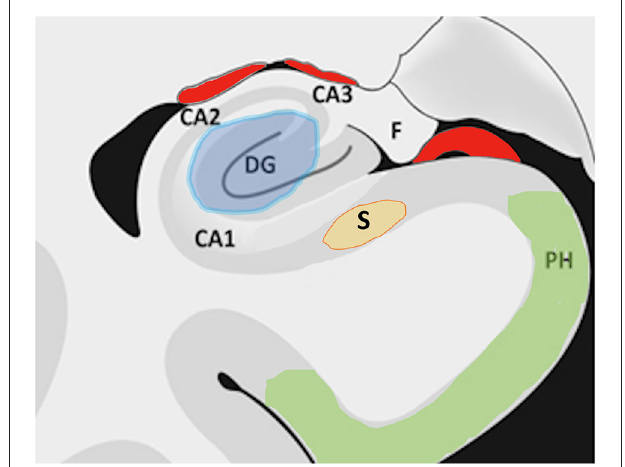
FIGURE 2 | Diagram of a coronal section of the temporal lobe that illustrates the size and location of the studied targets: in blue the hippocampus including dentate gyrus (DG) and Ammon fields C1–C3; subiculum (S); para-hippocampal cortex (PH). Notice the Hippocampus (DG + CA1-3) and Subiculum (S) are smaller and closer to the Sylvian